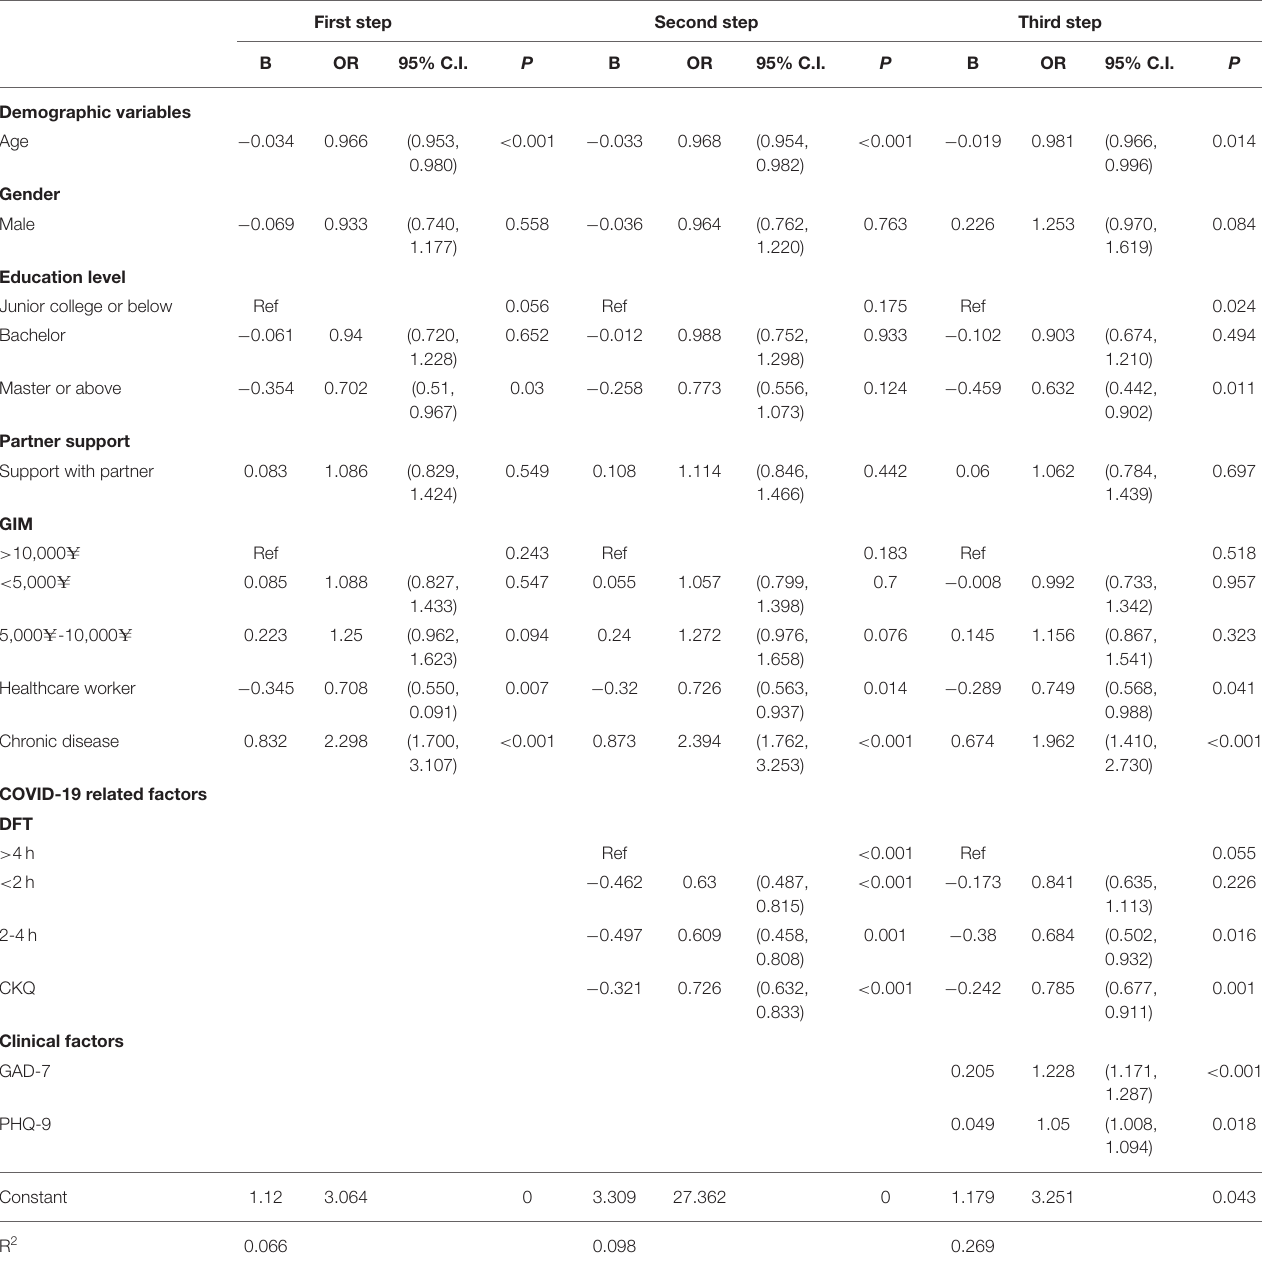
TABLE 3 | Hierarchical logistic regression analysis of HA related risk and protect